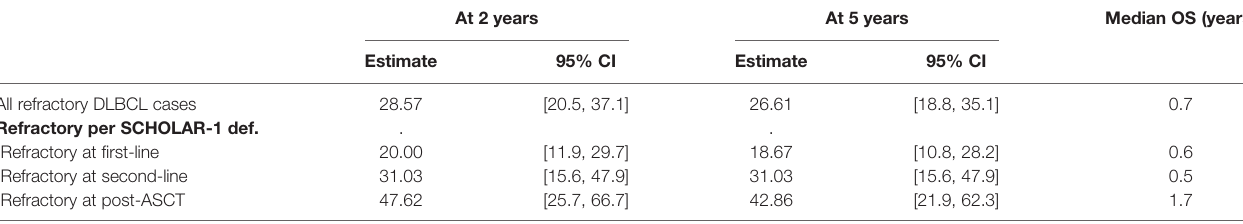
TABLE 3 | Observed survival of refractory DLBCL according to approximations of the SCHOLAR-1 (17) de fi